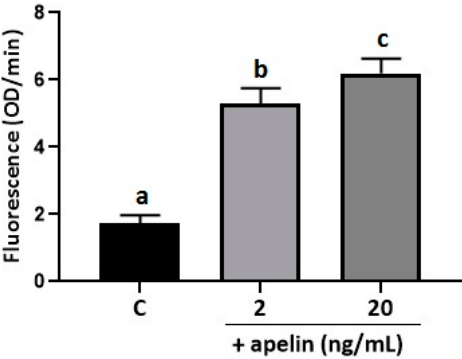
Figure 3. Effect of apelin on oxidative stress in BeWo cells. The cells were treated with apelin at 2 and 20 ng/mL for 24 h, and the oxygen consumption assay was performed. Experiments were in- dependently performed and repeated three times ( n = 3). The data are arranged as means ± SEM. Different letters indicate significant differences (p < 0.05) among groups; Control (C).